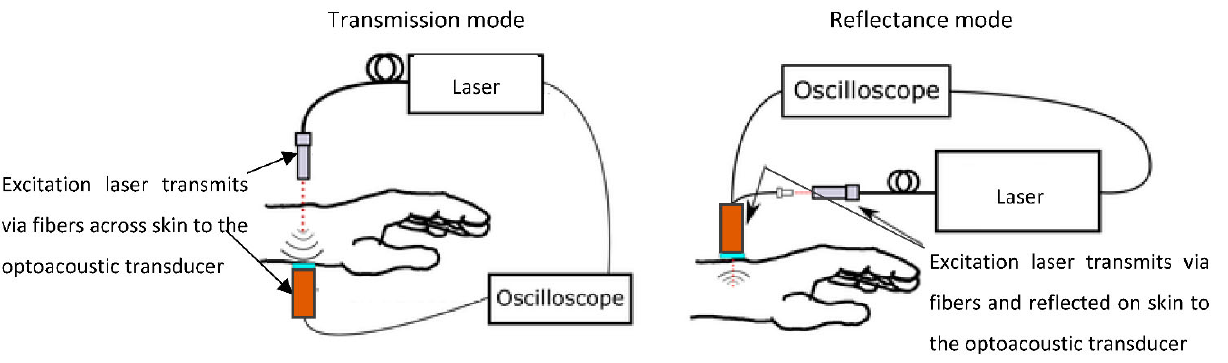
Figure 4. Experimental setup for OA measurements in the human wrist in the transmission mode and the reflection mode—modified from Perkov et al. [21].